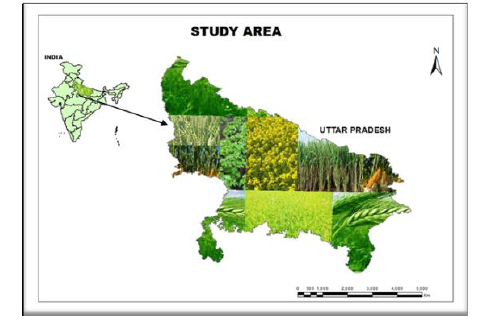
Figure 1. Study area (Uttar